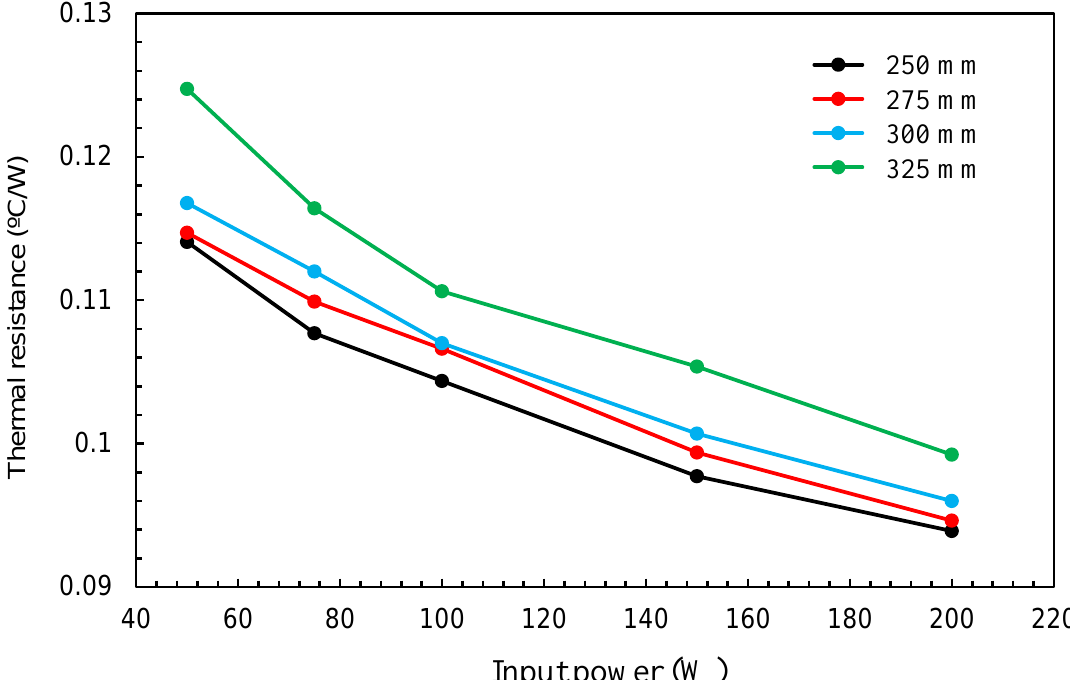
Figure 15. The effect of the central disk level on thermal resistance. (riser height = 550 mm, downcomer exit = 25 mm, FR = 50%, inclination angle = 90°).